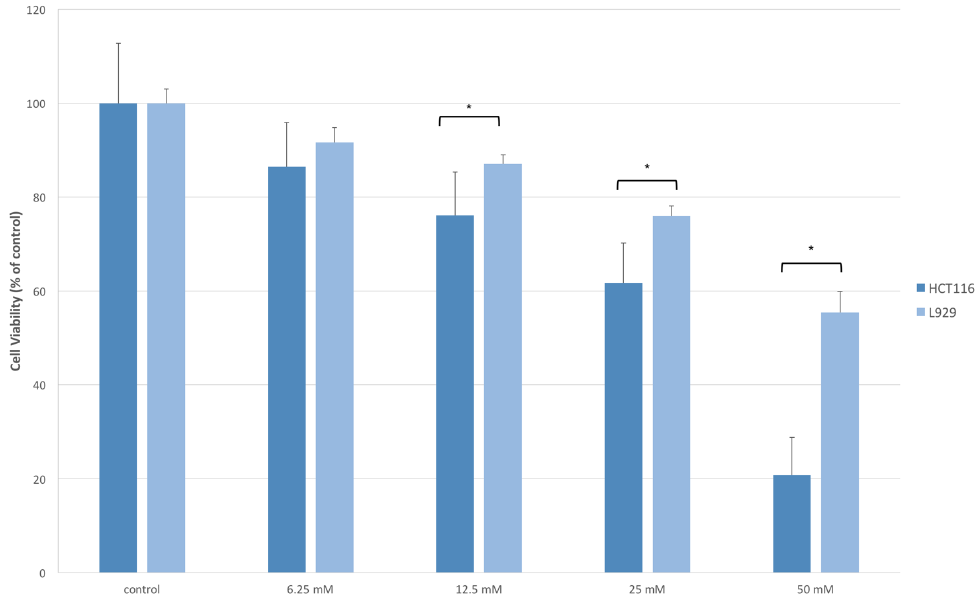
Figure 4. HCT116 colon cancer cells and L929 fibroblast cells were treated with 6.25–50 mM concentrations of NaB before detecting cell viability with a MTT assay. The 6.25 mM NaB treatment did not show a significant effect on the cell viability of L929 cells; whereas, the 12.5–50 mM NaB treatment significantly inhibited L929 cell viability ( p < 0.05). NaB (12.5–50 mM) treatment exhibited more cytotoxic activity towards HCT116 cells compared to L929 cells ( p < 0.05).